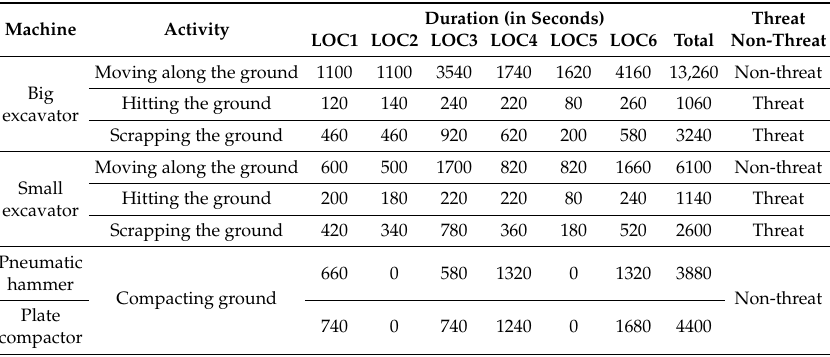
Table 3. Example of table showing details on an experimental database in which different